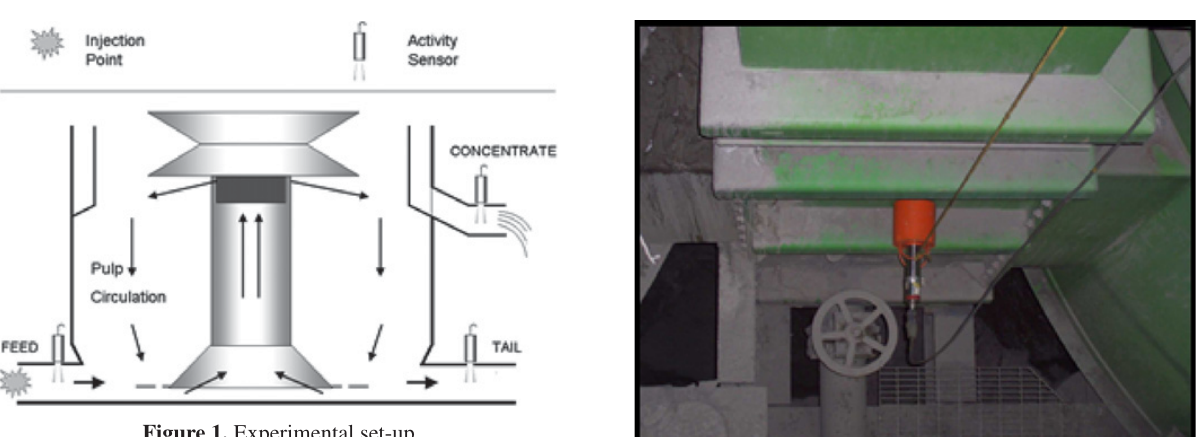
Figure 1. Experimental set-up.